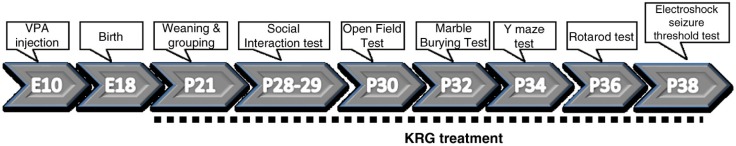
The experiment scheme shows the main step periods from in utero VPA exposure to long-term postnatal KRG treatment along with the behavior tests employed.